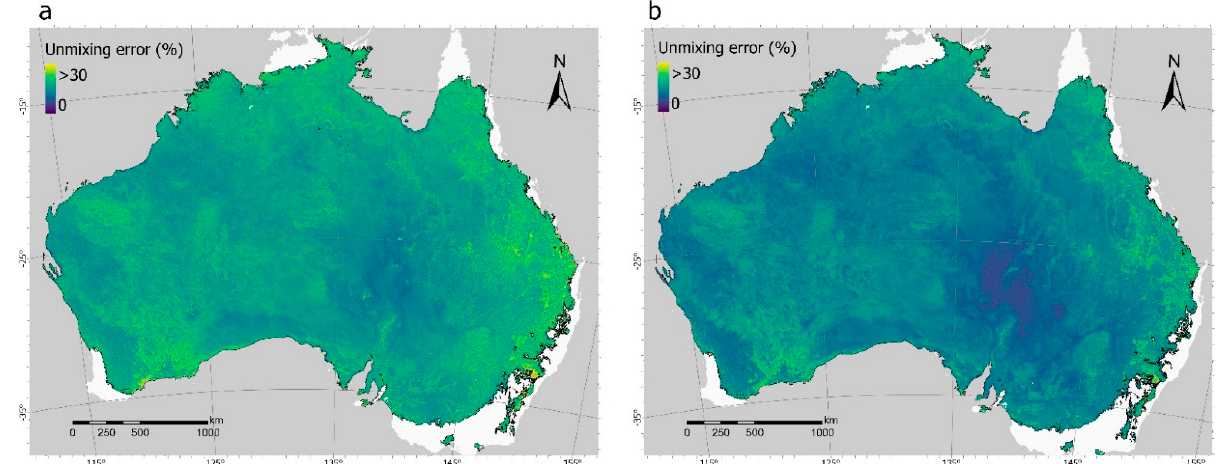
Figure 7. Unmixing error images within drylands of ( a ) a wet year (2016) and ( b ) a dry year (2019). The clustered spatial distribution of relatively high UE values in distinct patches suggests that the model quality may be influenced by non-random characteristics of the surface. UE values tend to be higher near the dryland’s boundary for both years (Figure 8). The spatial distribution of these error patterns matches the distribution of landscapes with high tree cover density (i.e., forests) and over 15 m of height (Figure 2) [55]. The unmixing error consistently increased in response to shifts in tree density classes (Figure 8). Within each tree cover density class, there is a positive UE response to height class shift. This is particularly evident for the height class shift from “very tall” (mean UE = 18.31%) to “extremely tall” (mean UE = 27.91%) within the “Open Forest” tree cover density class (Figure 9). Moreover, moderate yet significant correlations ( p < 0.01) were found between unmixing error and the observed cover fractions (except with NPV). The unmixing error tended to increase with the proportion of green vegetation, and more weakly decrease as the bare soil fraction increased (Figure A3).